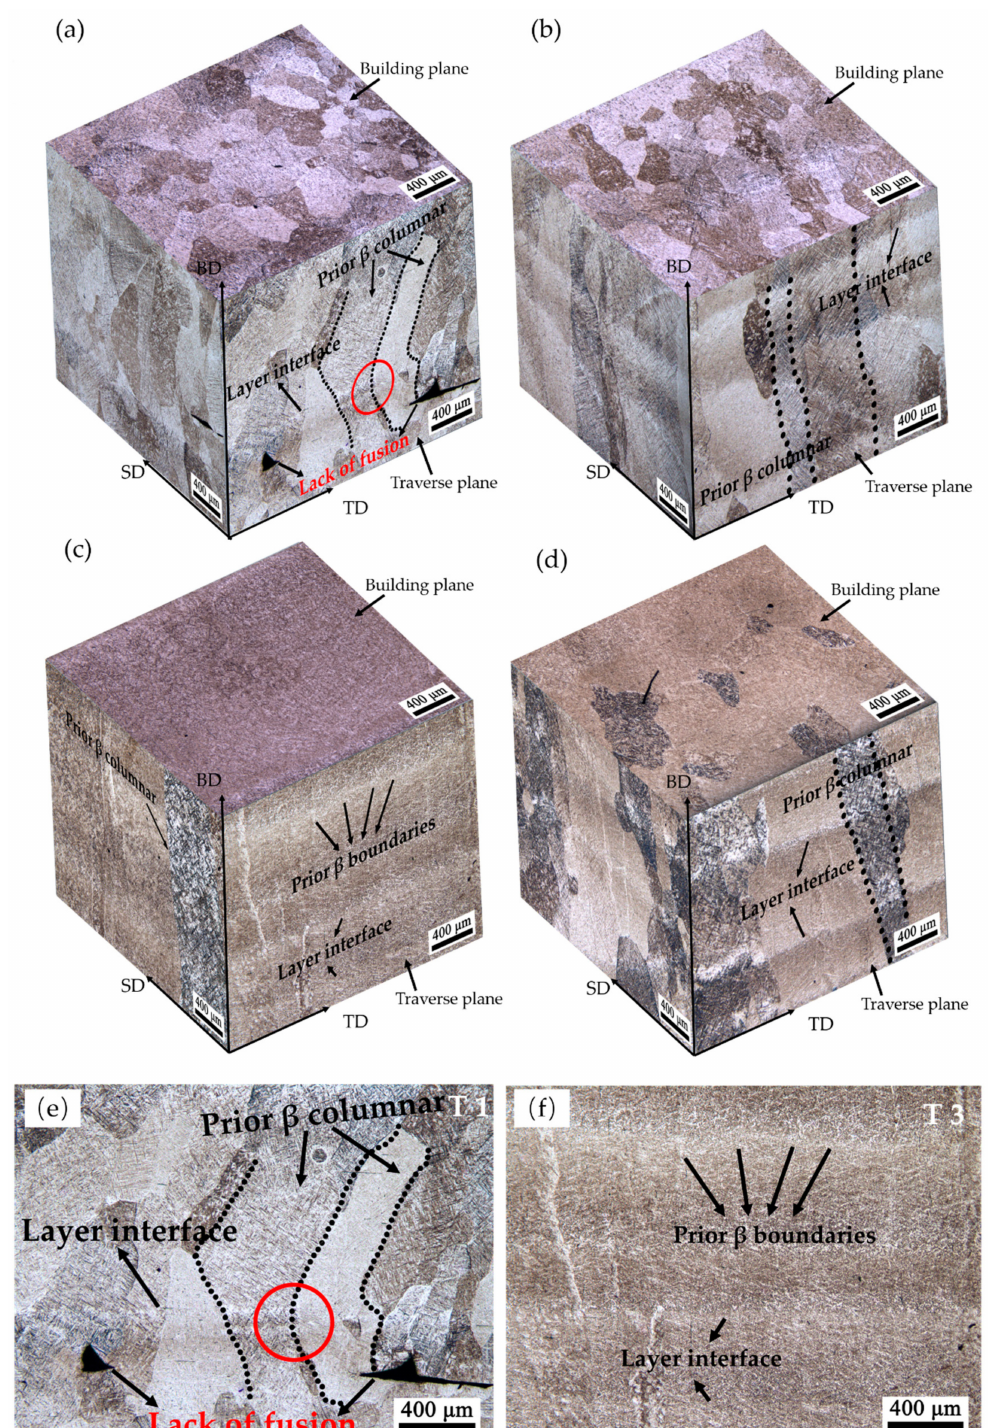
Figure 6. The 3D representative meso-structure of di ff erent LMD Ti6Al4V samples: ( a ) T1, ( b ) T2, ( c ) T3, and ( d ) T4. ( e ) The magnification image in the traverse plane of T1. ( f ) The magnification image in the traverse plane of